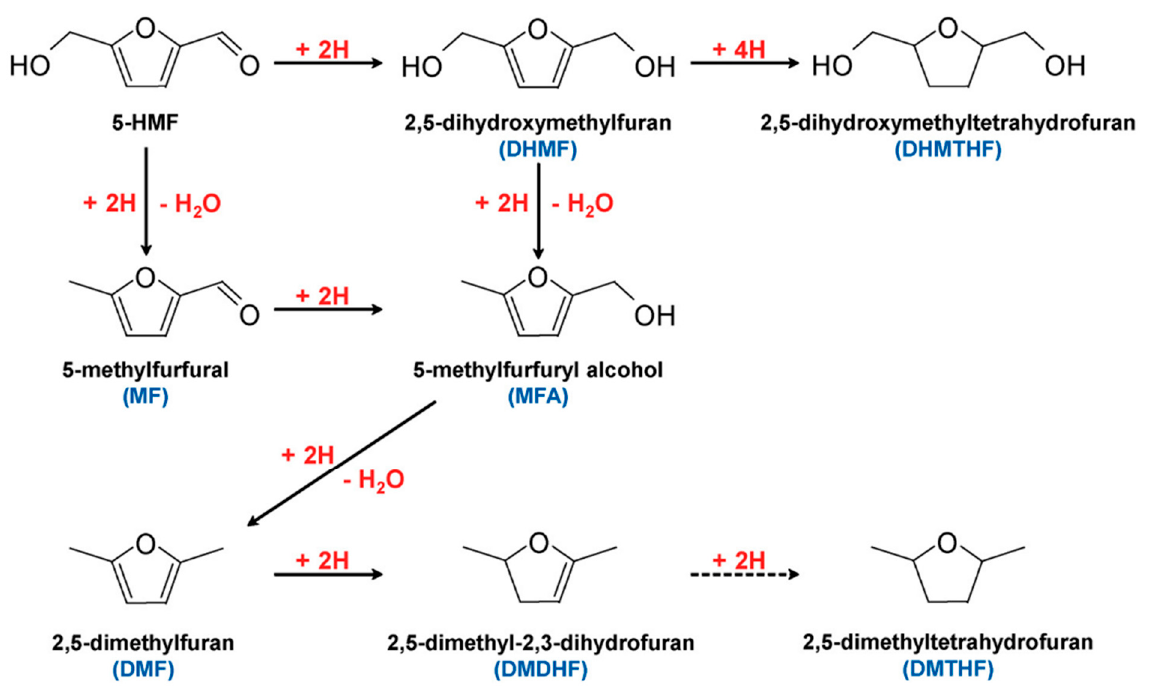
Figure 16. Hydrogenation pathways of 5-HMF. Reprinted with permission from Ref. [92]. Copyright 2015, ChemSusChem.